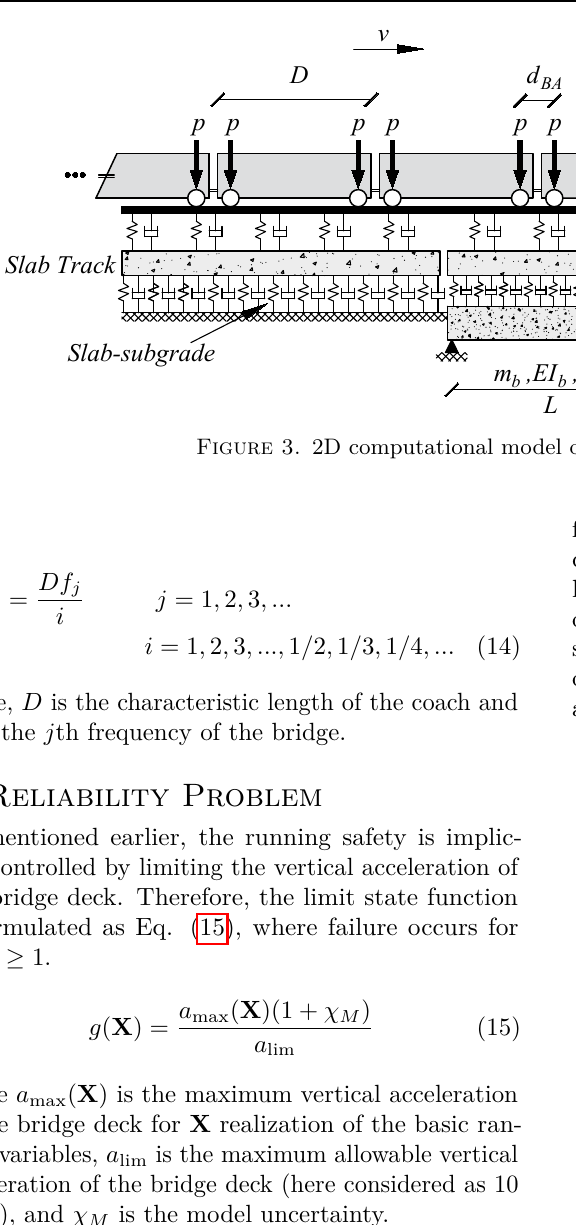
Figure 4. Sensitivity to the number of